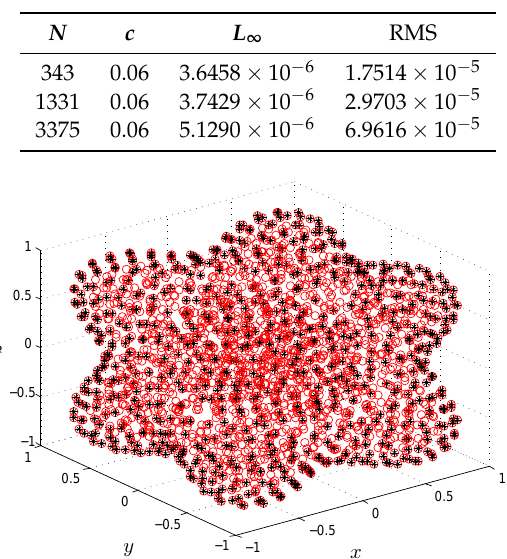
Table 5. Error norms for Problem 5.